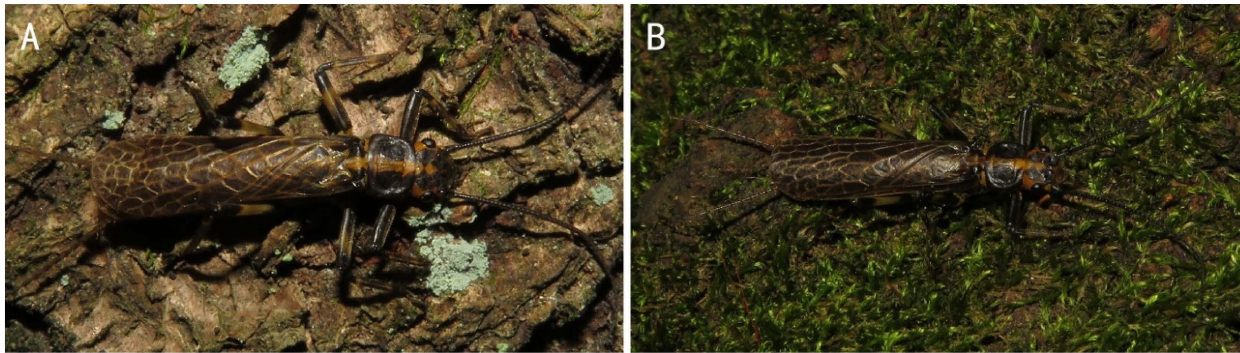
Figure 13. Filchneria zhouchangfai from Anhui, males on the tree trunks with few lichens ( A ) and multiple mosses ( B